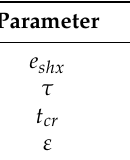
Table A2. Sewage heat exchanger model parameters.